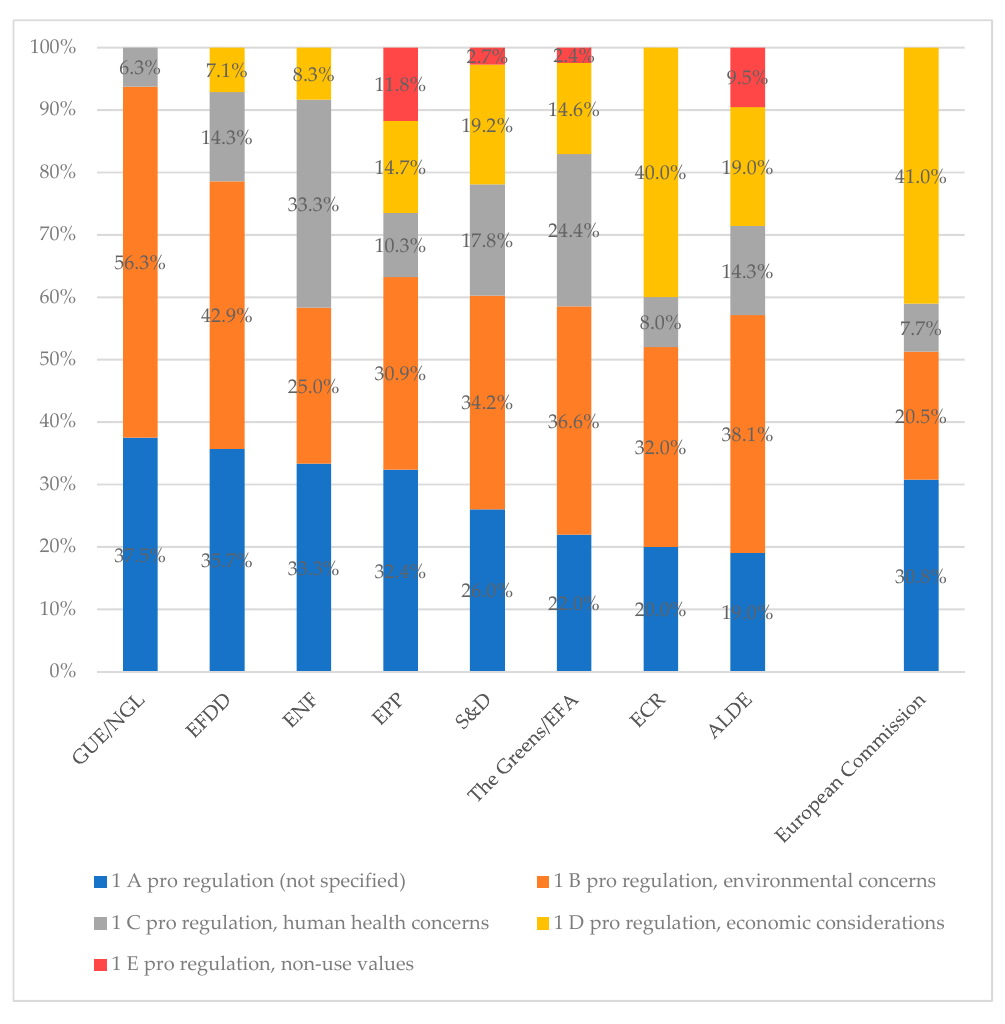
Figure 3. Sub-category frequencies for category 1 (pro regulation) per parliamentary group and for the European Commission.